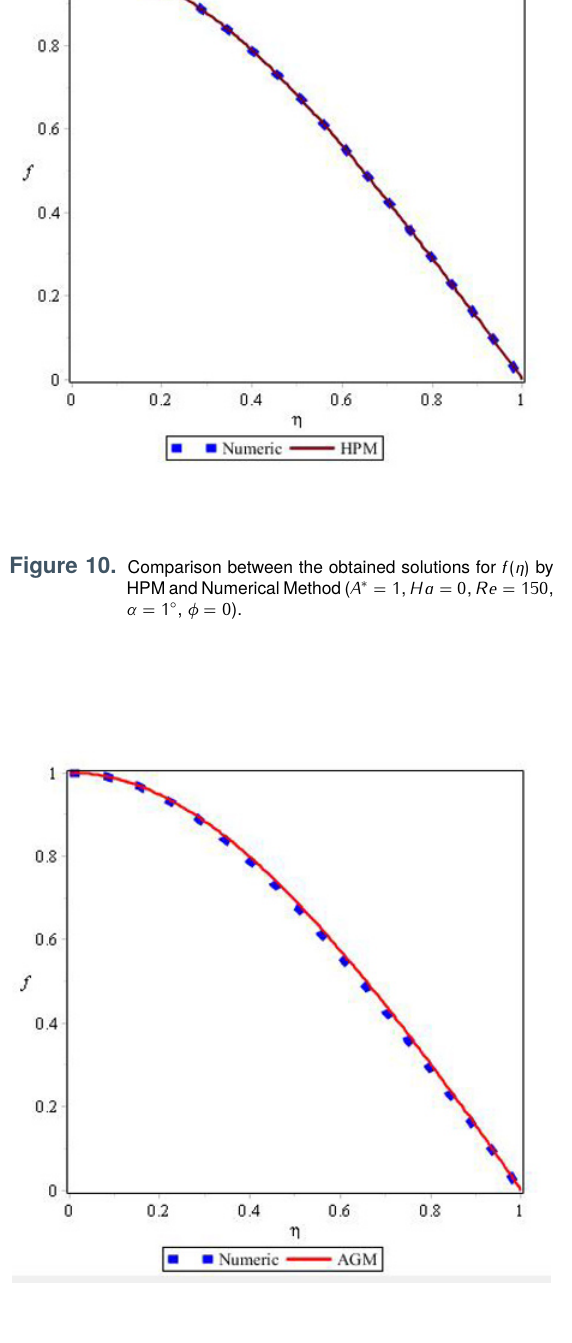
Figure 13. Comparison between the obtained solutions for f ( η ) by AGMandNumericalMethod( A ∗ = 1 , Ha = 0 , Re = 150 , α = 1 ◦ , φ = 0